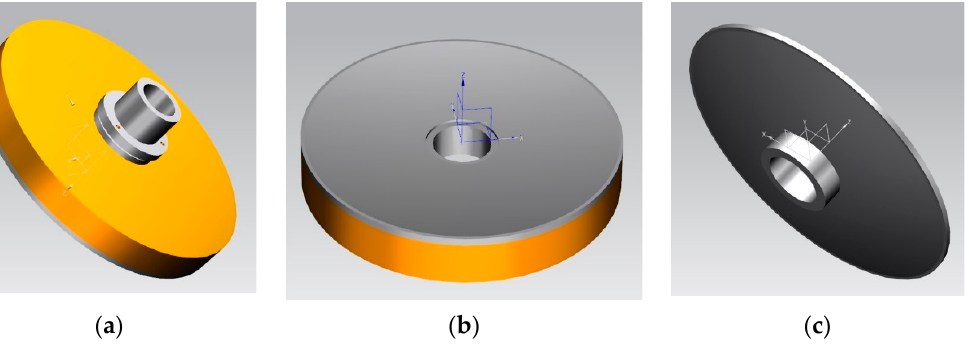
Figure 5. The primary mirror of the Cassegrain system. ( a ) The components of the primary mirror; ( b ) The structure of the annular mirror; ( c ) The non-design domain of the annular